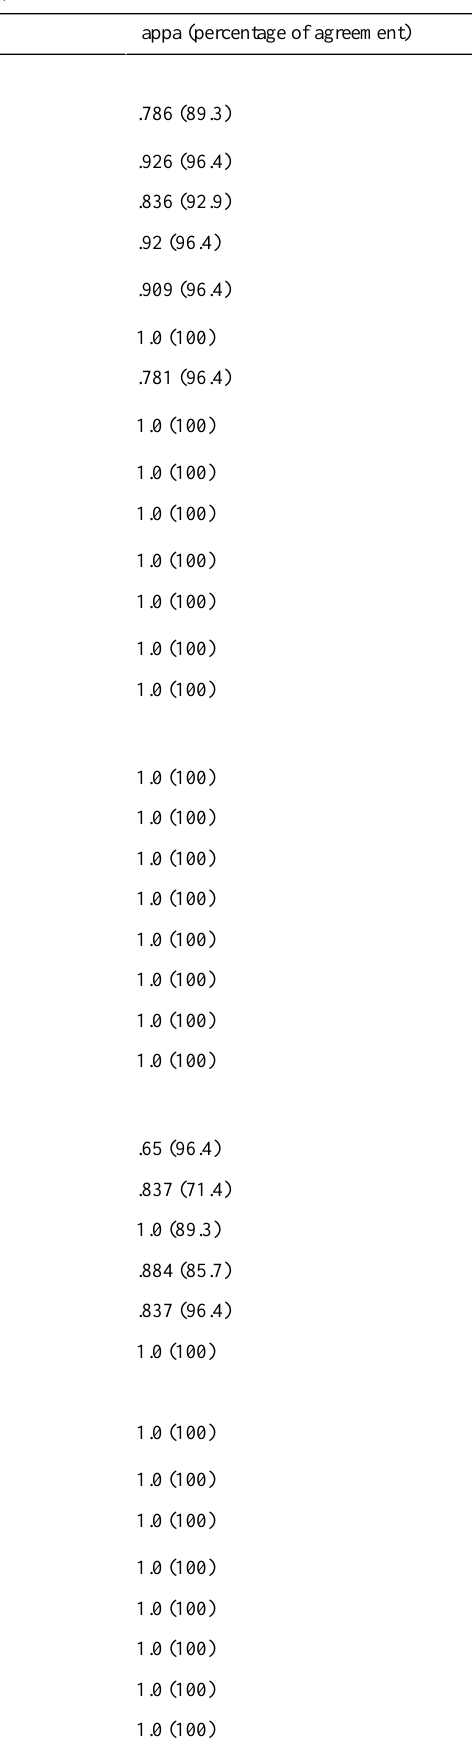
Table 2. Persuasive design principles and number of apps (N=28) that used the